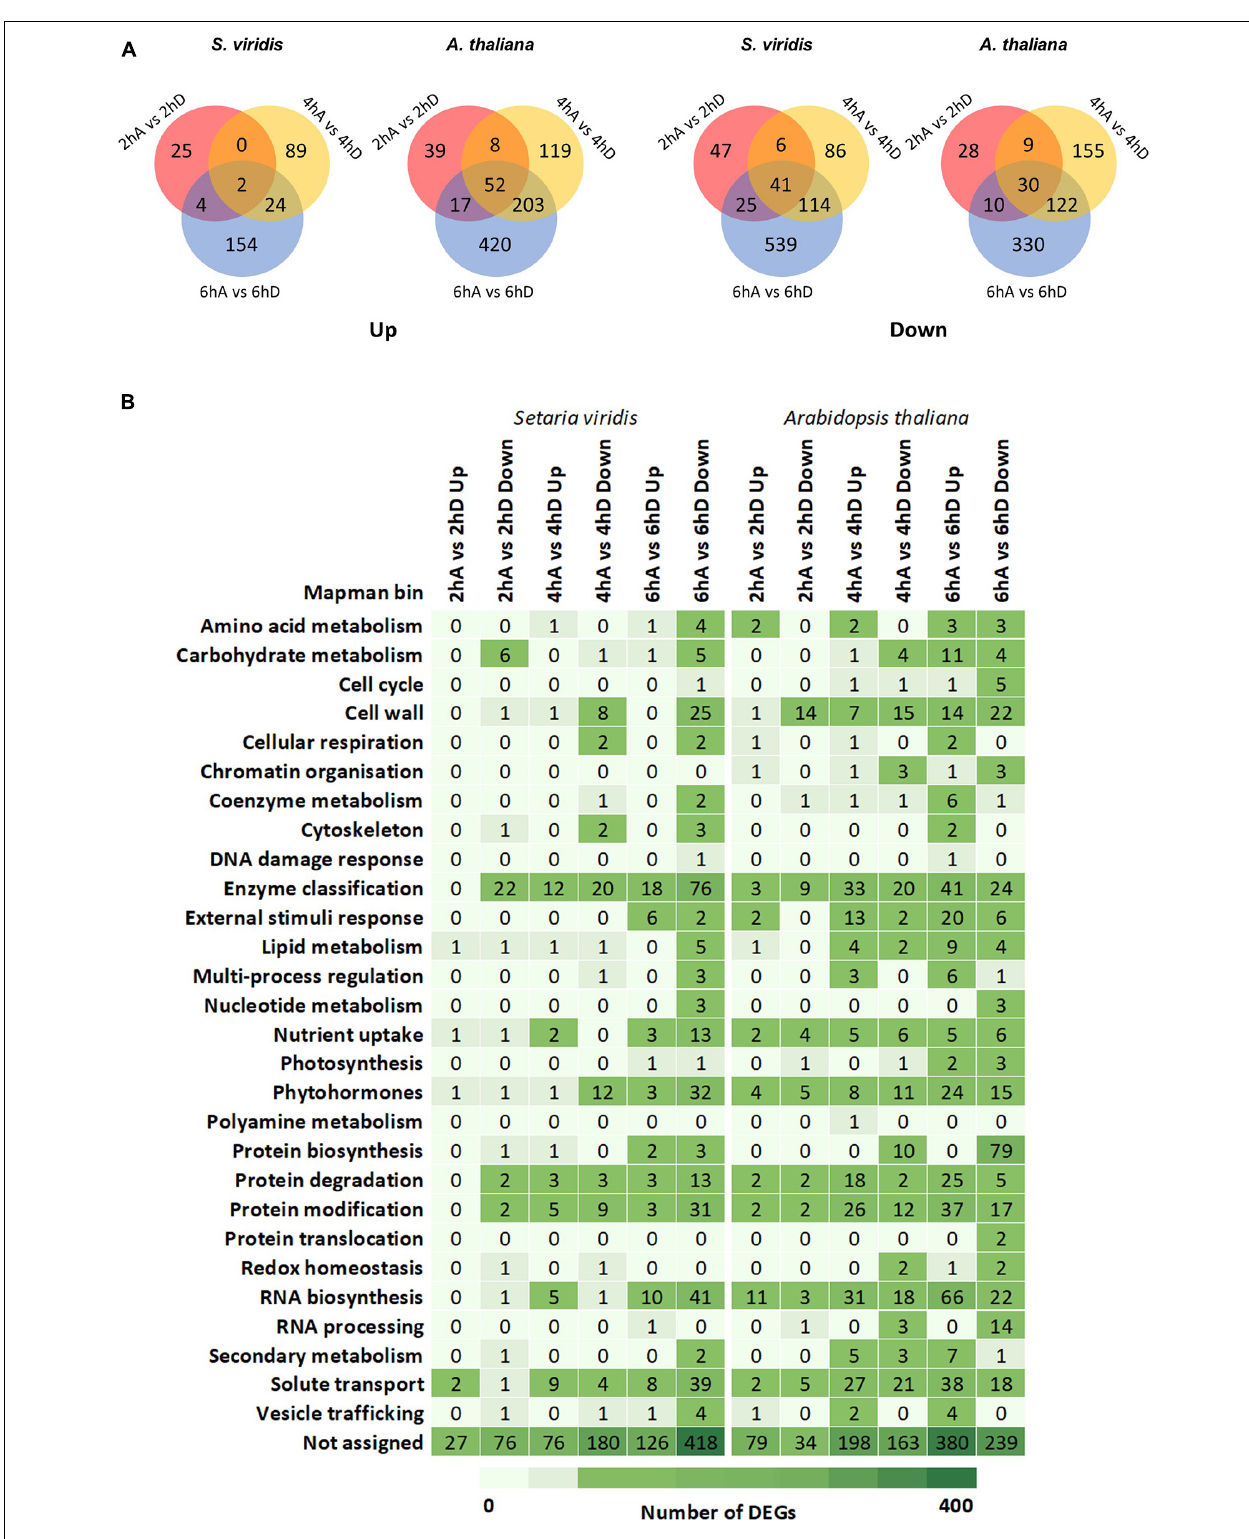
FIGURE 5 | Comparative transcriptional changes in S. viridis and A. thaliana under TOR inhibition. (A) Venn diagrams of DEGs among distinct time points under TORC inhibition in S. viridis and A. thaliana , showing down- and up-regulated genes. (B) Classification of DEGs into Mapman categories in S. viridis and A. thaliana seedlings under TORC inhibition. The list of DEGs from control and TOR-inhibited seedlings is available on Supplementary Dataset 8 .